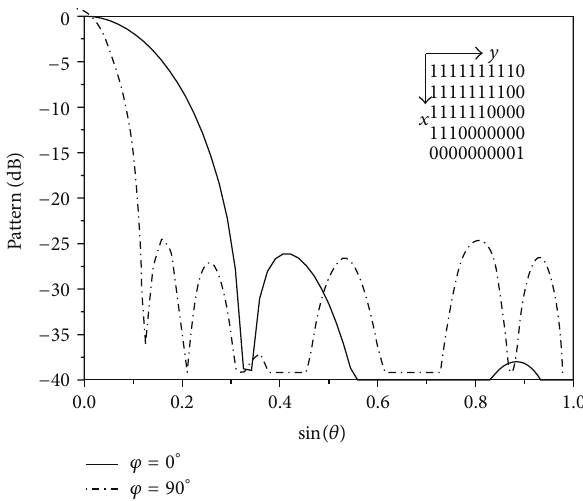
Figure1:Radiationpatternsoftheoptimized 20×10 -elementplanar array with the fitness function as (7).